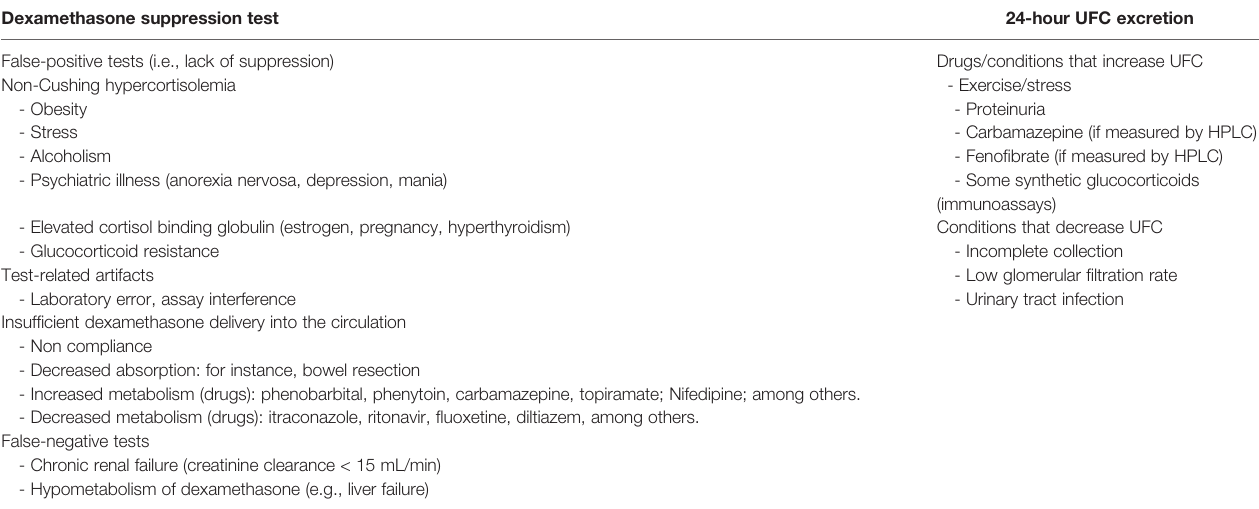
TABLE 2 | Pitfalls in the interpretation of the dexamethasone suppression test and 24-hour urinary free-cortisol excretion. Dexamethasone suppression